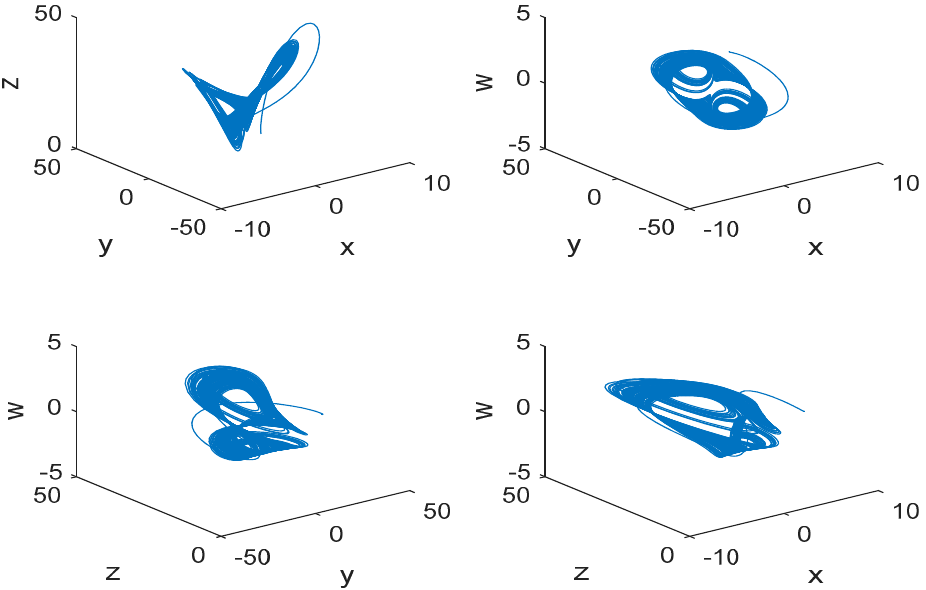
Figure 1. Chaotic attractors of the Lorenz-Stenflo system (1) in three-dimensional (3D) spaces with a = 1, b = 0.7, c = 26, r =